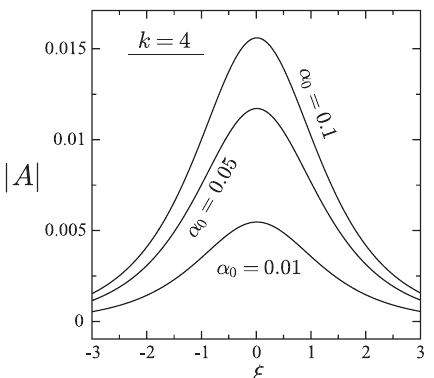
Fig. 5 The real amplitude | A | for | ξ | (cid:3) 3 expressed by Eq. (93). The initial void fraction is chosen as α 0 = 0 . 1, 0 . 05, and 0 . 01, the wavenumber is fixed as k = 4, and other quantities are the same as those used in Fig. 4. The height of the envelope soliton decreases with the decrease in α 0 .